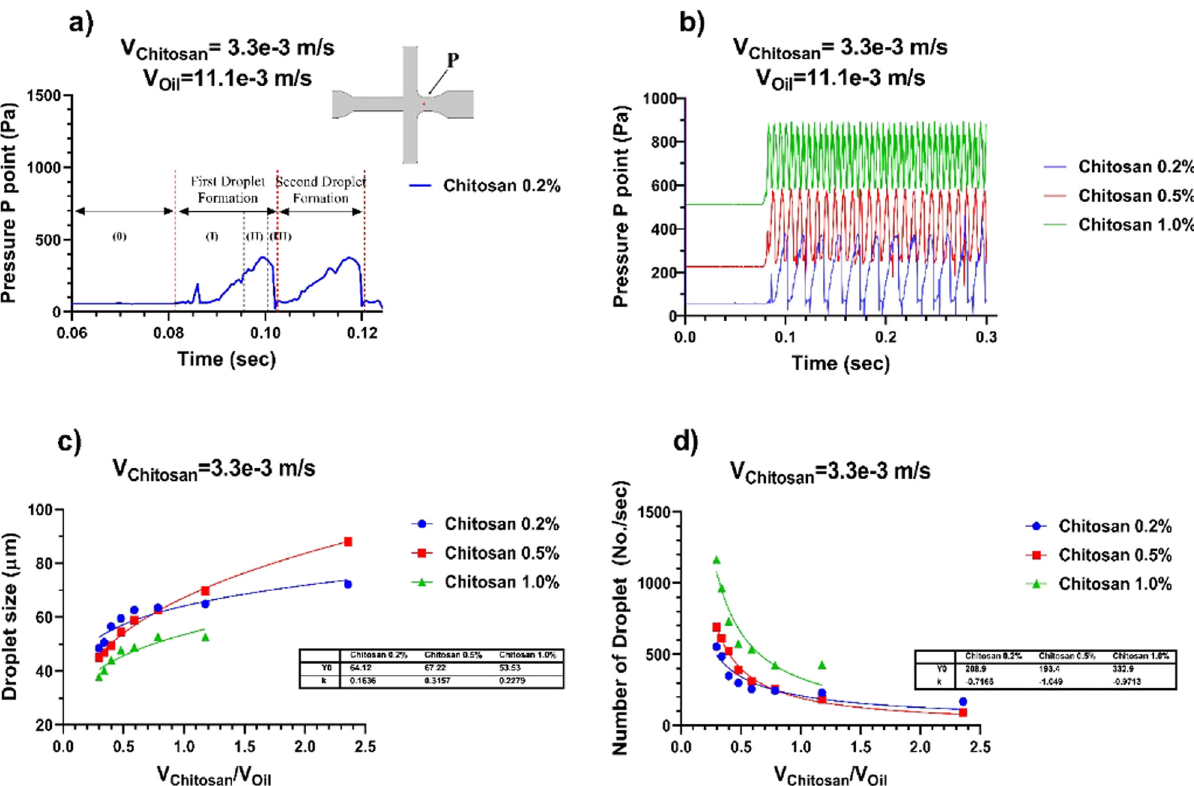
Figure 4: ( a ) Dynamic pressure behaviour on the place of P point at the time of droplet creation. The P point de fi nes the point placed at the main conduit entry and indicates the evolvement of the droplet making mechanism. Droplet production process: ( I ) lag stage, ( II ) fi lling stage, and ( III ) necking stage. ( b ) The software simulation outcomes to the pressure of the composite streamline as a function of time at the place of P point for three ratios of the composite ( 0.2%, 0.5%, and 1.0% [ w/v ]) . ( c ) and ( d ) In fl uences of velocity and ratios of the composite upon diameter and number of droplet creation per unit time. The velocity of vegetable oil is changed in the range of 1.4 – 11.1 mm/s, and the composite velocity is adjusted at 3.3